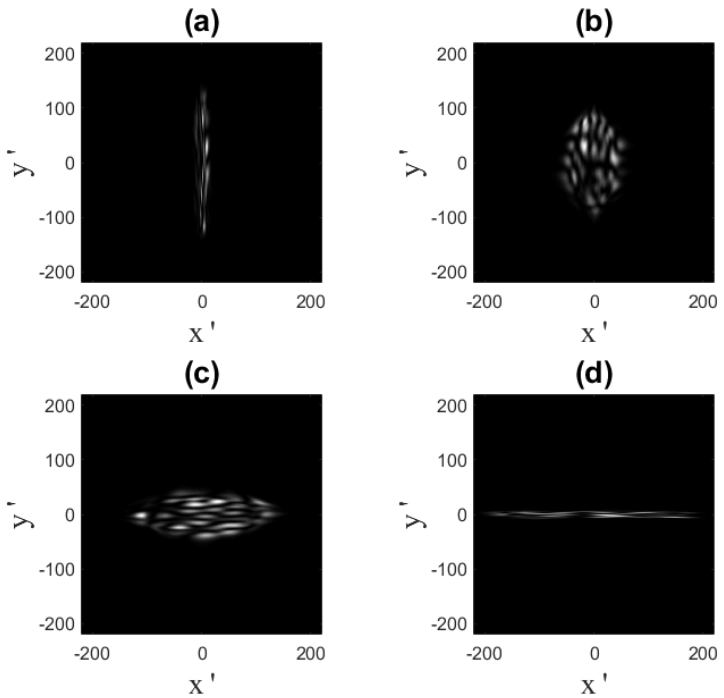
Figure 6. Interferometric images of 4 sand particles located at 4 different longitudinal positions: z 1 = 0.40 m ( a ), z 1 = 0.36 m ( b ), z 1 = 0.31 m ( c ), and z 1 = 0.27 m ( d